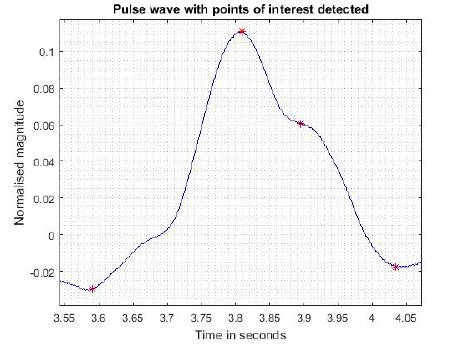
Figure 8. Pulse wave with points of interest